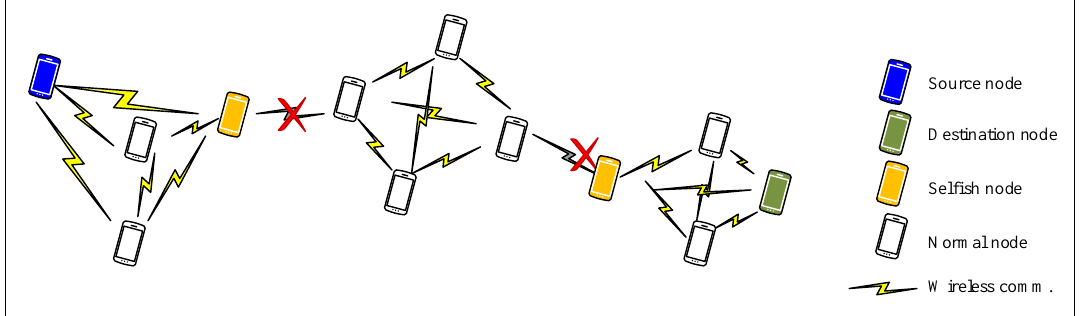
Figure 1. An example of network partitioning caused by the presence of selfish nodes in a mobile ad hoc network